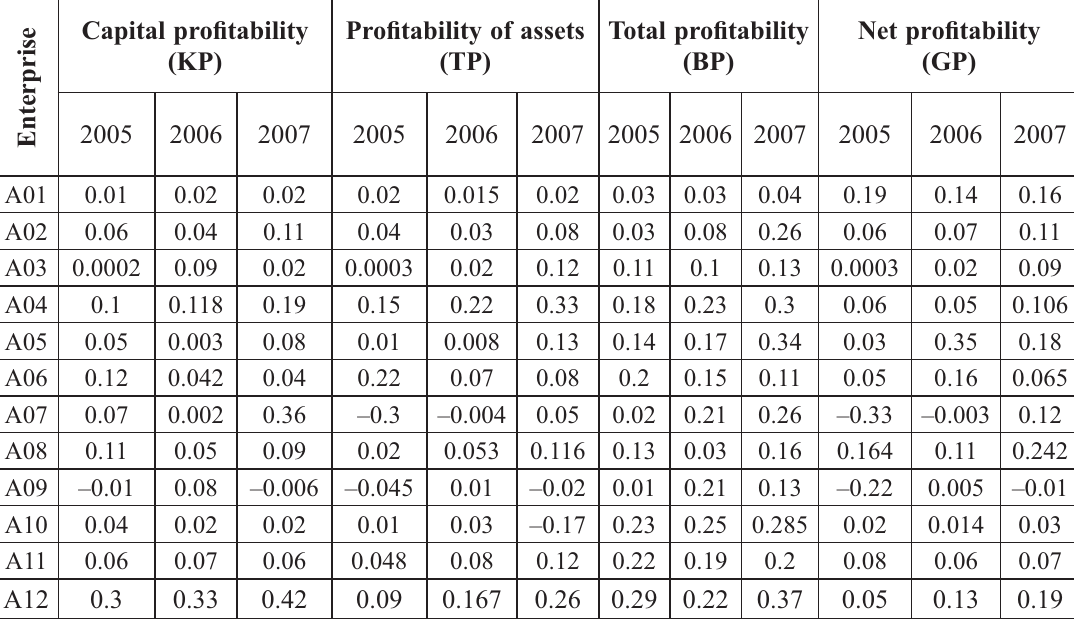
Table 4. Indicators of enterprise profitability in